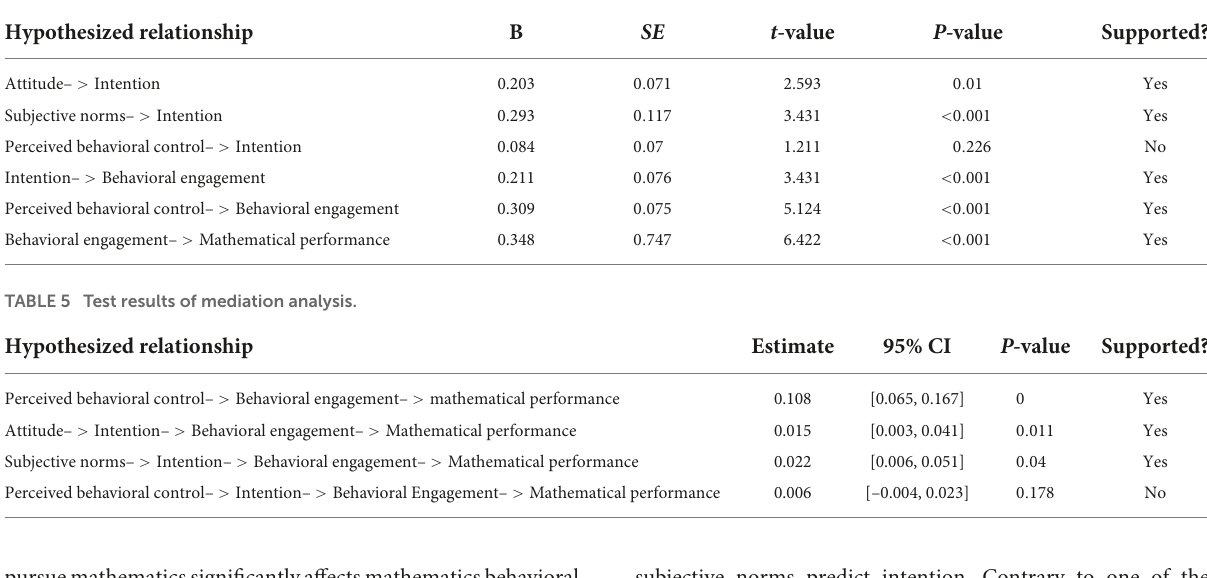
TABLE 4 Test results of path relationship.